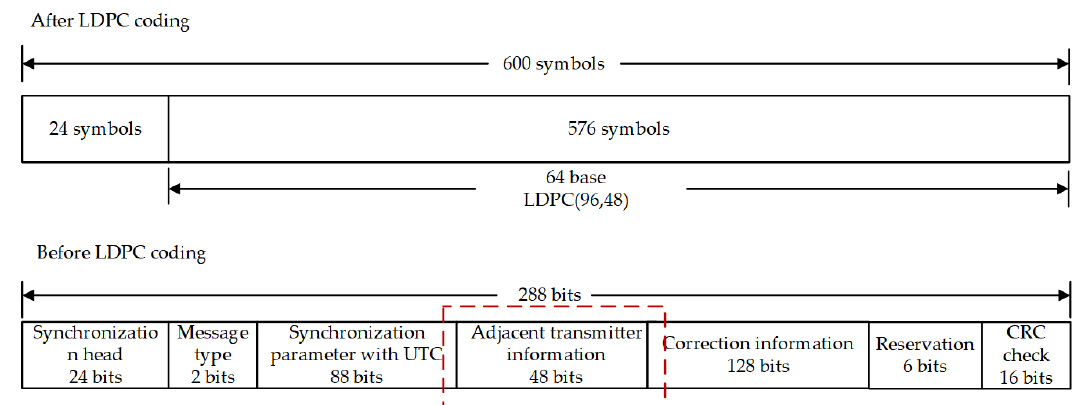
Figure 6. Second frame of navigation message.